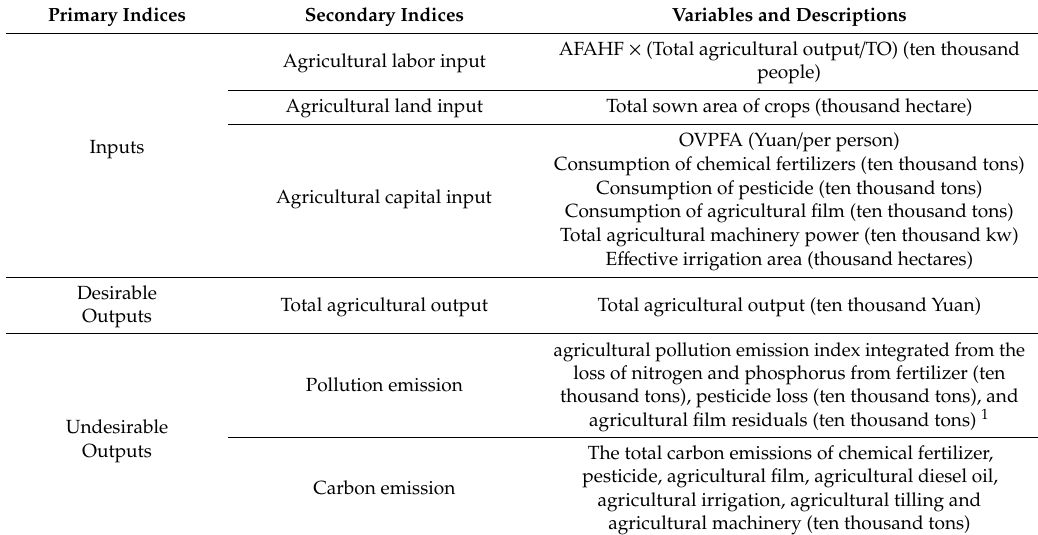
Table 1. The input and output indicators for the cultivated land green utilization e ffi ciency (GUECL)